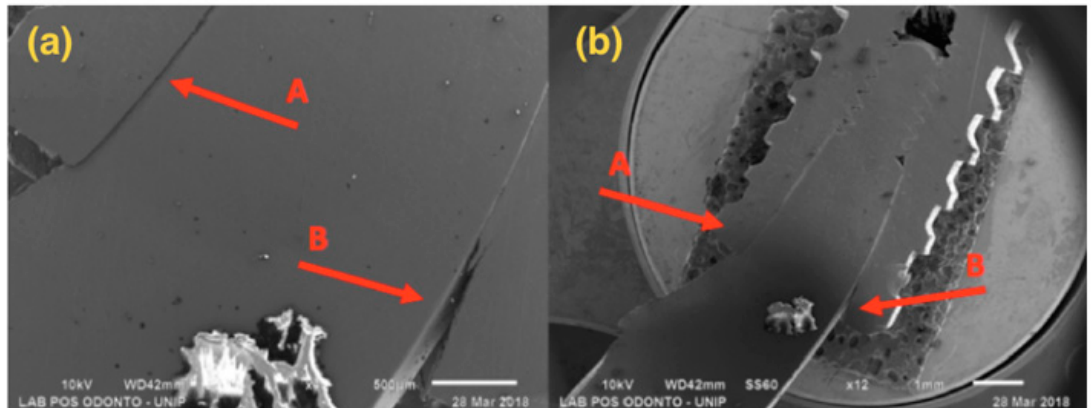
Figure 7. G4: SEM: ( a ) Magnification of 45 × ; ( b ) Magnification of 12 × ; A—Compression at the abutment / implant interface; B—Opening at the abutment / implant interface.